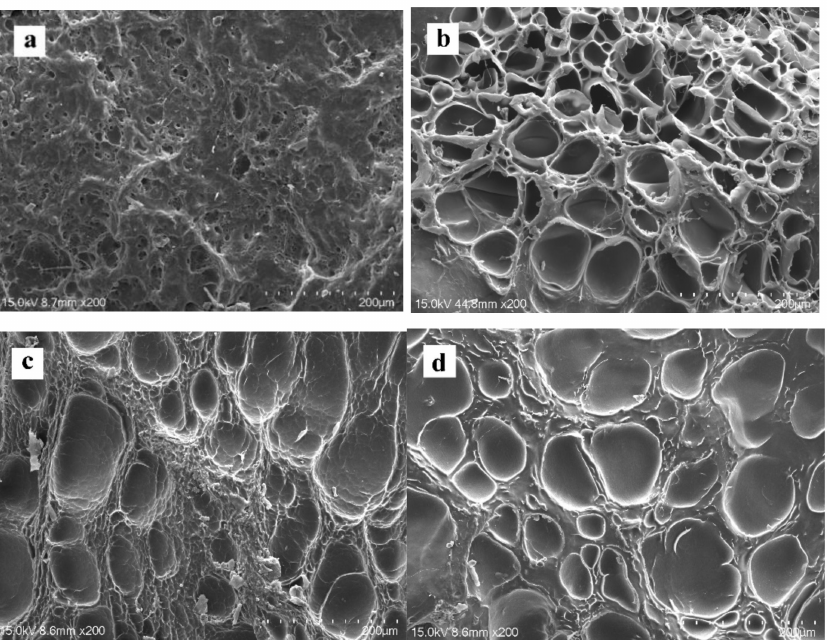
Figure 5. Surface and cross-sectional microstructure of SP composite scaffolds ( × 200): ( a ) the surface of pure SF scaffold; ( b – d ) cross section structures of pure SF scaffold, SF/WS (10%) and SF/ILS (20%) composite 3D, respectively; All scales are 200 µ